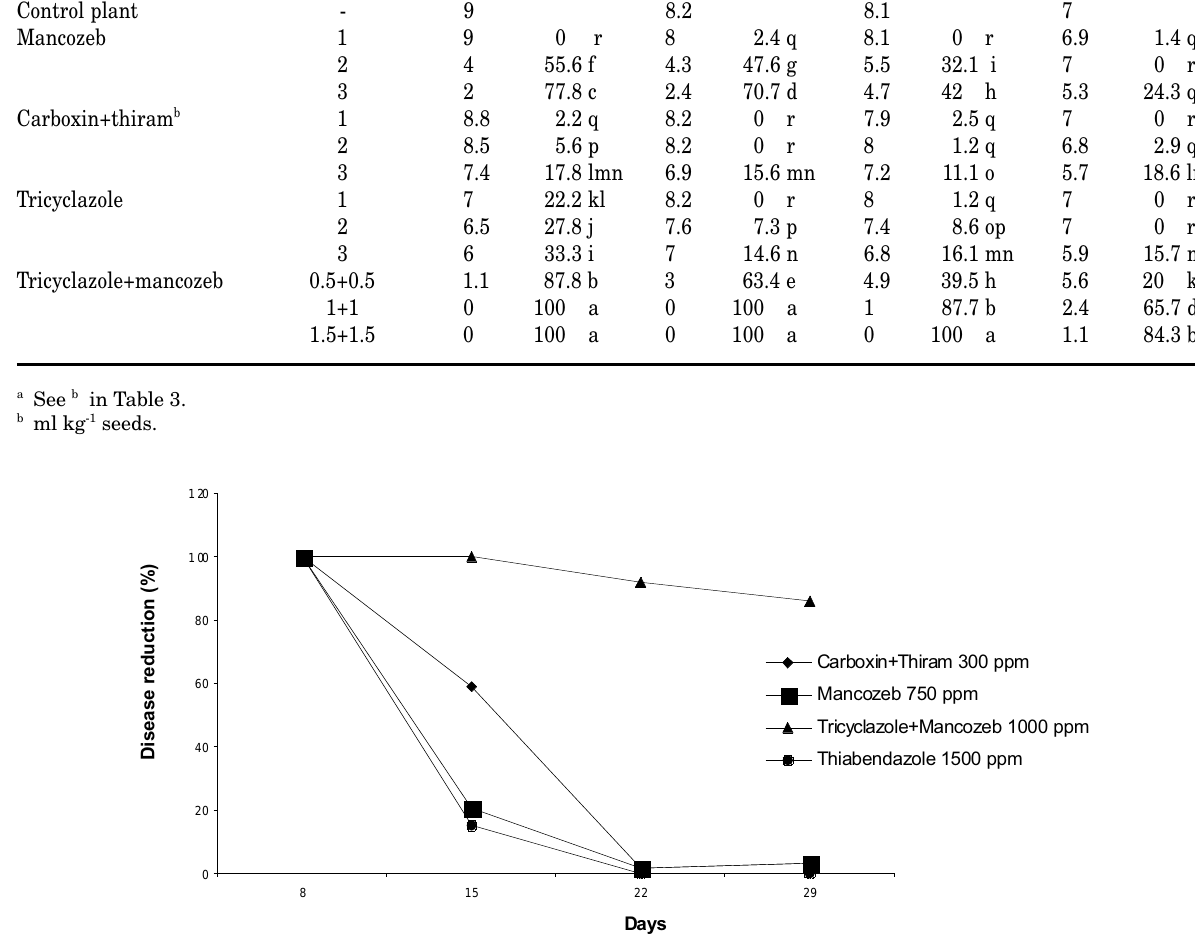
Fig. 2. Percent reduction of brown spot on rice plants inoculated with Helminthosporium oryzae 8, 15, 22 and 29 days after treatment